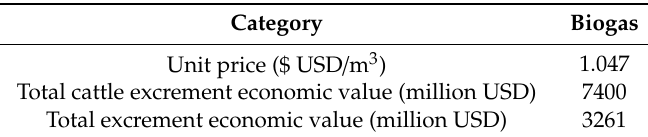
Table A2. Economic value of excrements [28].